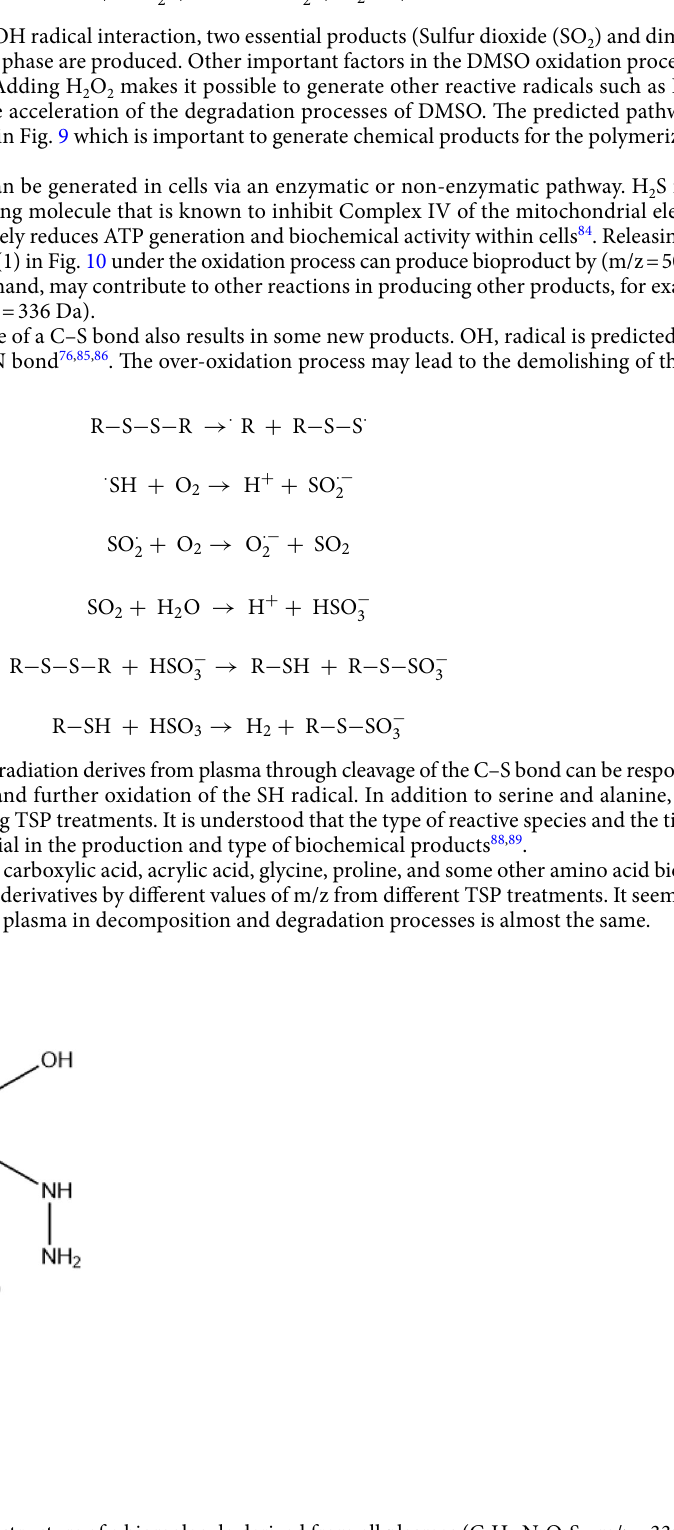
Figure 8. Predicted chemical structure of a biomolecule derived from all plasmas (C 6 H 13 N 3 O 9 S 2 , m/z = 336